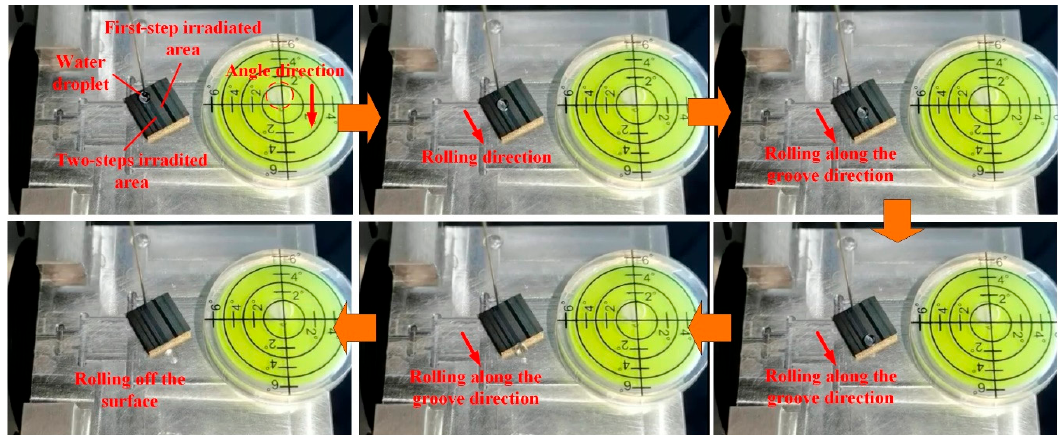
Figure 13. Functional surface with self-cleaning property.